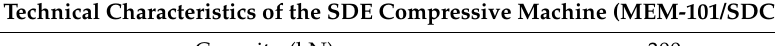
Table 4. Technical characteristics of the compressive machine.